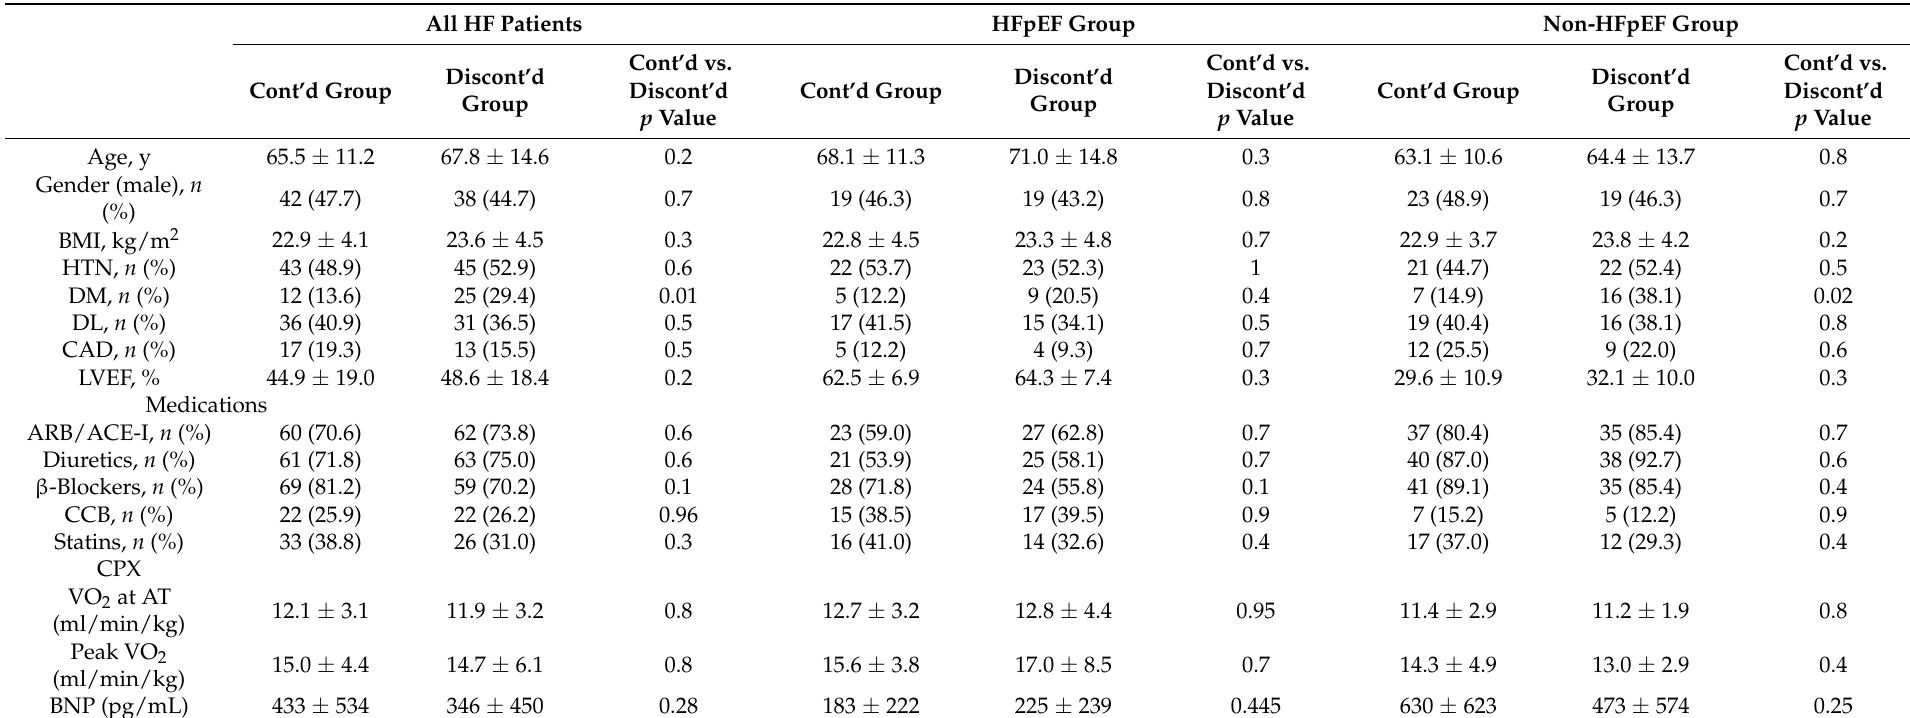
Table 3. Patient characteristics at baseline in the continued and discontinued groups in all HF patients and HFpEF and non-HFpEF